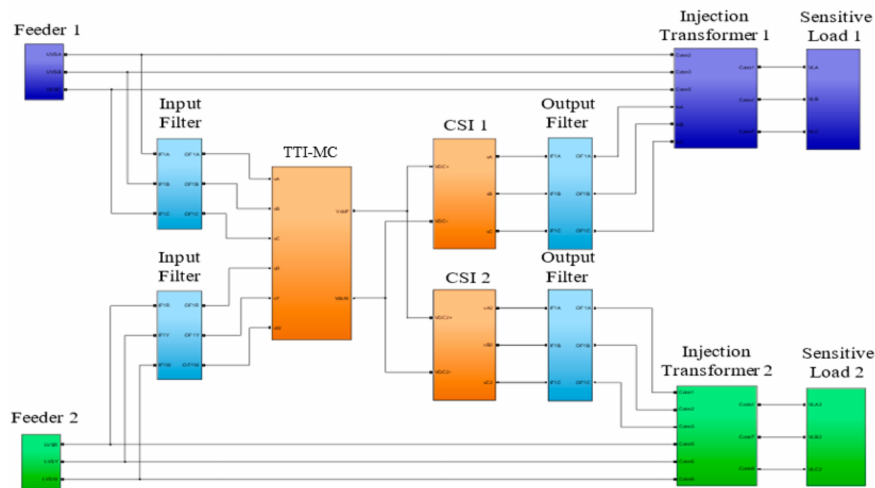
Figure 8. Implemented model in Simulink of the proposed